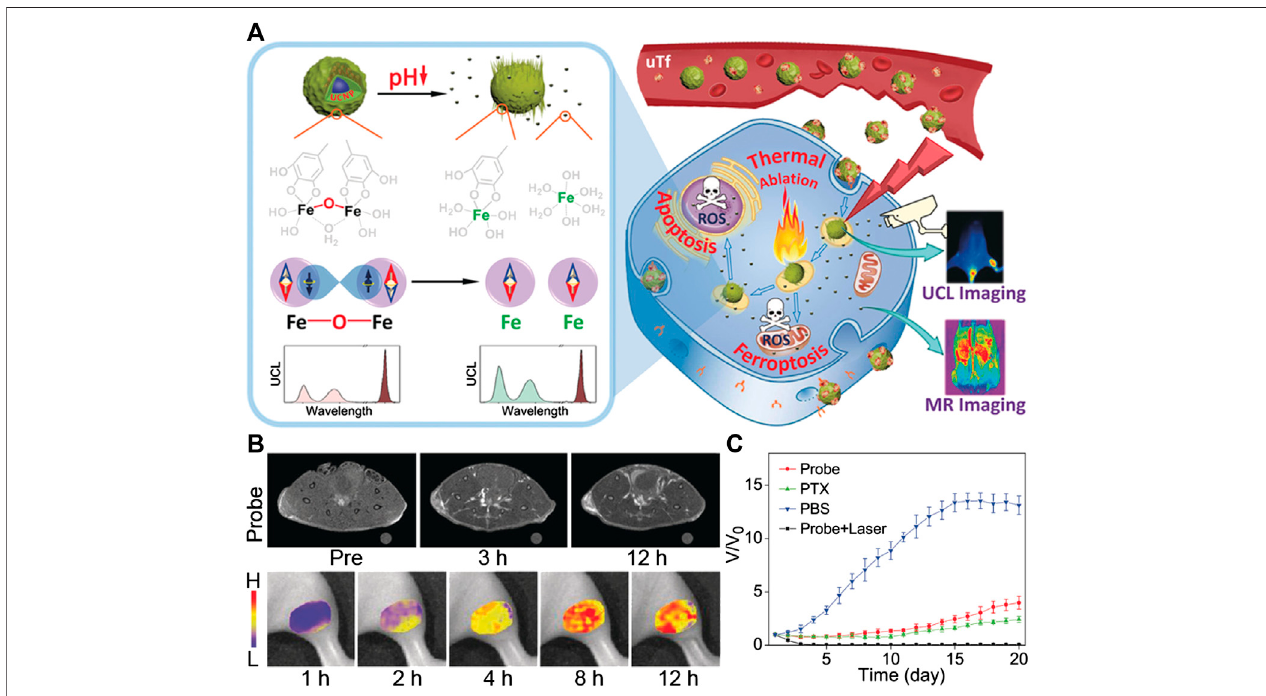
FIGURE 2 | (A) Illustration to demonstrate the activatable function of UCNP@GA-FeIII probe for MRI and its therapeutic function involving multiple pathways. (B) T 1 -weighted MR images of tumor-bearing mice acquired at different time points pre- and post-injection of UCNP@GA-FeIII probe (upper) , and mapping of Fe 3+ release based on I 475 /I 800 ratio of upconversion luminescence (bottom) . (C) the tumor growth curves in different groups of mice after treatment. Reproduced with permission from Zhang P. et al. (2019a). Copyright 2019 Wiley-VCH Verlag GmbH & Co.